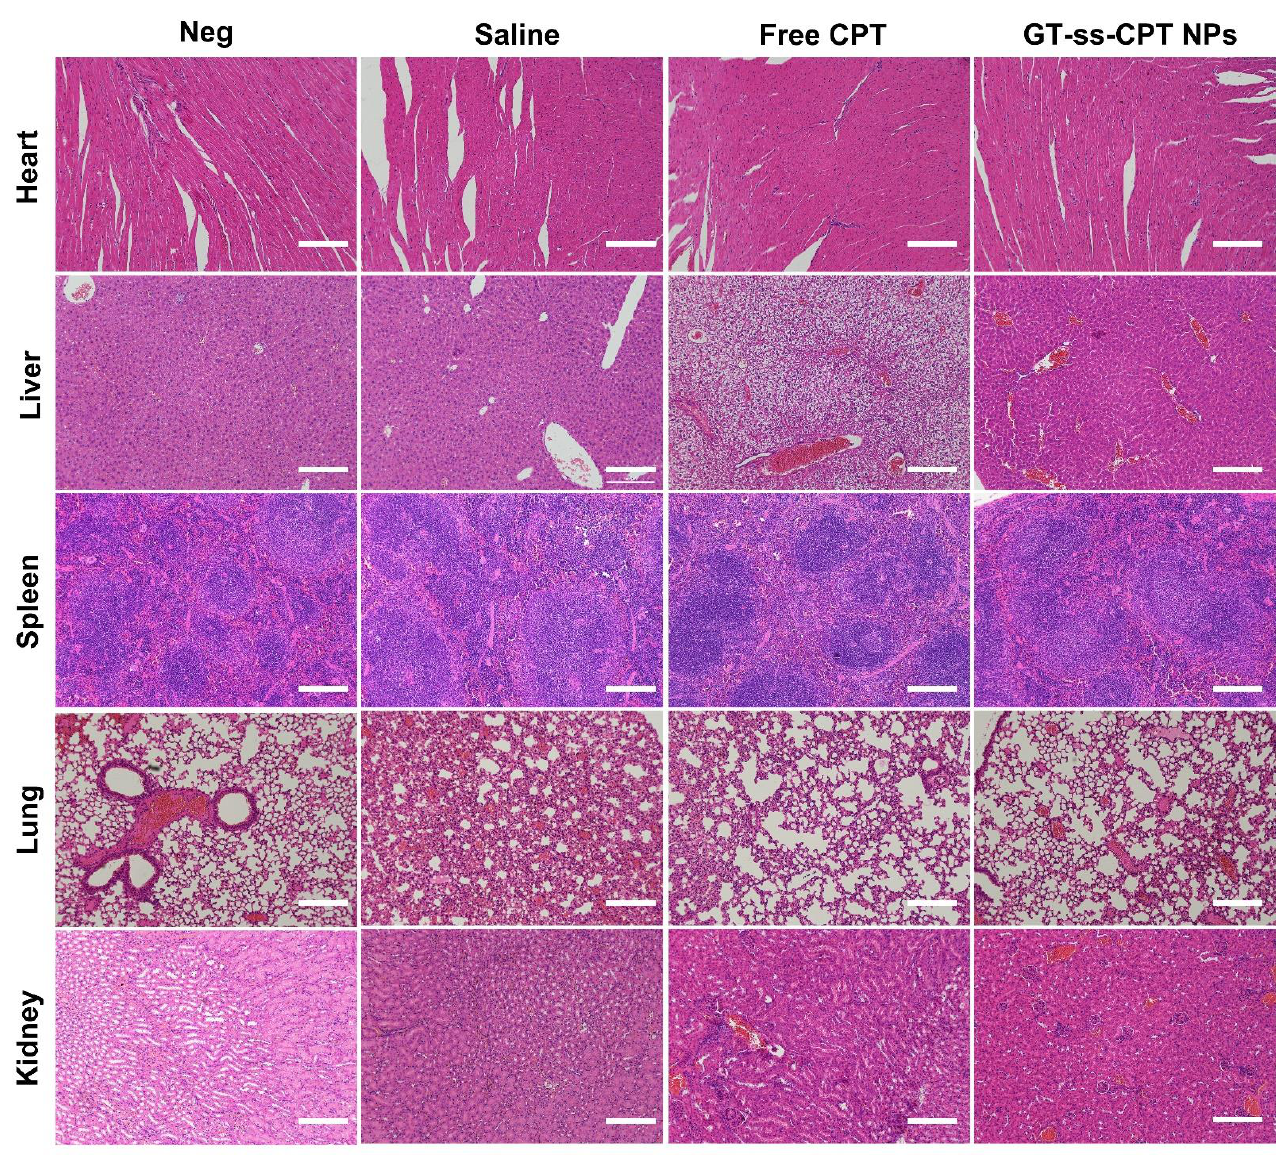
Figure 7. H&E staining images of major organs in H22 tumor-bearing mice treated with saline, free CPT, and GT-ss-CPT NPs at the end of in vivo antitumor trials. Organs from healthy mice were given as negative (Neg) controls. Magnification: 200×.